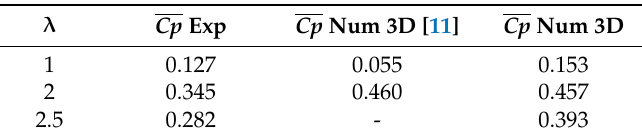
Table 3. Comparison of experimental results of the average power coefficient with the URANS numerical simulations at different λ .